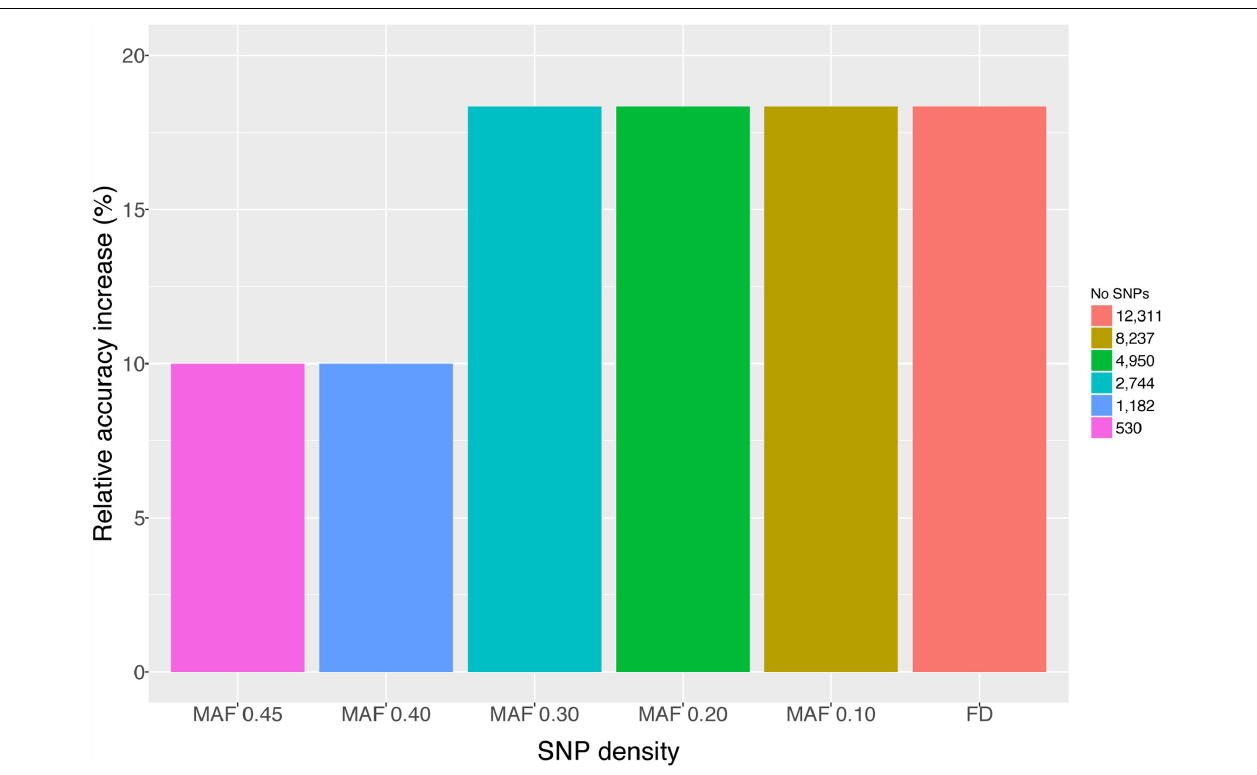
FIGURE 3 | Mean accuracies of GBLUP and PBLUP. GBLUP accuracies were obtained using either all available SNPs (FD; 12,311), SNPs with MAF > 0.10 (8,237), SNPs with MAF > 0.20 (4,950), SNPs with MAF > 0.30 (2,744), SNPs with MAF > 0.40 (1,182), and SNPs with MAF > 0.45 (530).